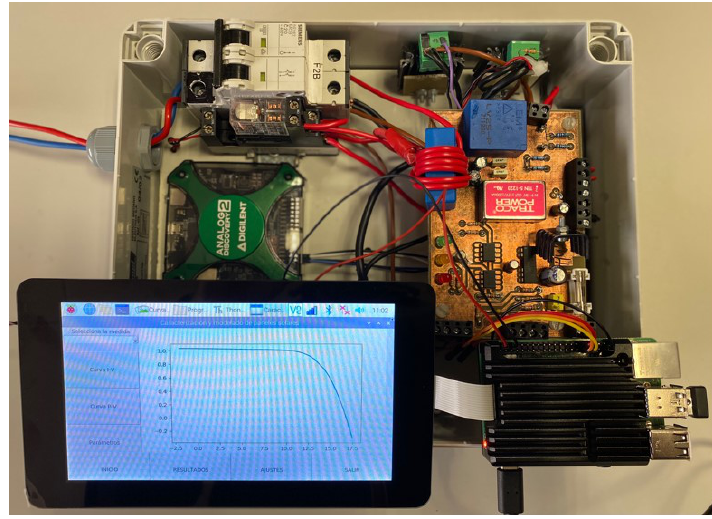
Figure 8. I–V curve tracer system (not